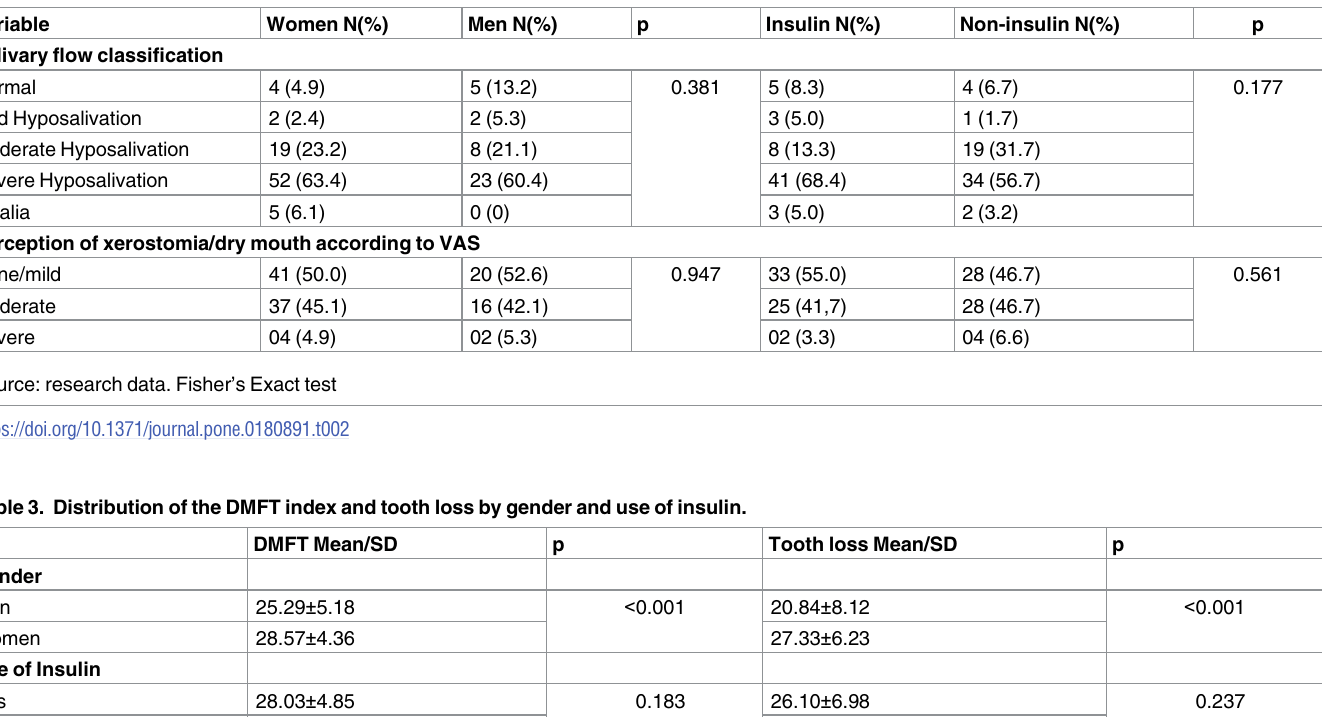
There was a mean of 2.06 ± 3.42 filled teeth. The analysis of DMFT (p < 0.001) and tooth loss (p < 0.001) by gender revealed a statistically significant association with female gender com- pared to men. Tooth loss occurred due dental caries in 57 (47.5%) patients; periodontitis in 7 (5.8%) patients; and due to both diseases in 56 (46.7%) patients. Insulin-dependent individuals had a greater number of missing teeth, with a mean of 26.10±6.98 missing components compared to a mean of 24.45±7.94 missing teeth in non-insu- lin dependent individuals. However, there was no statistically significant difference (Table 3).